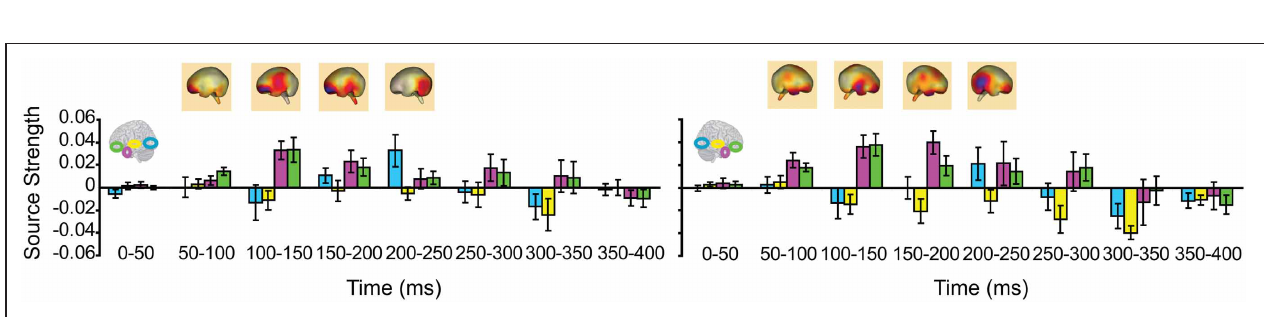
Frontiers in Integrative